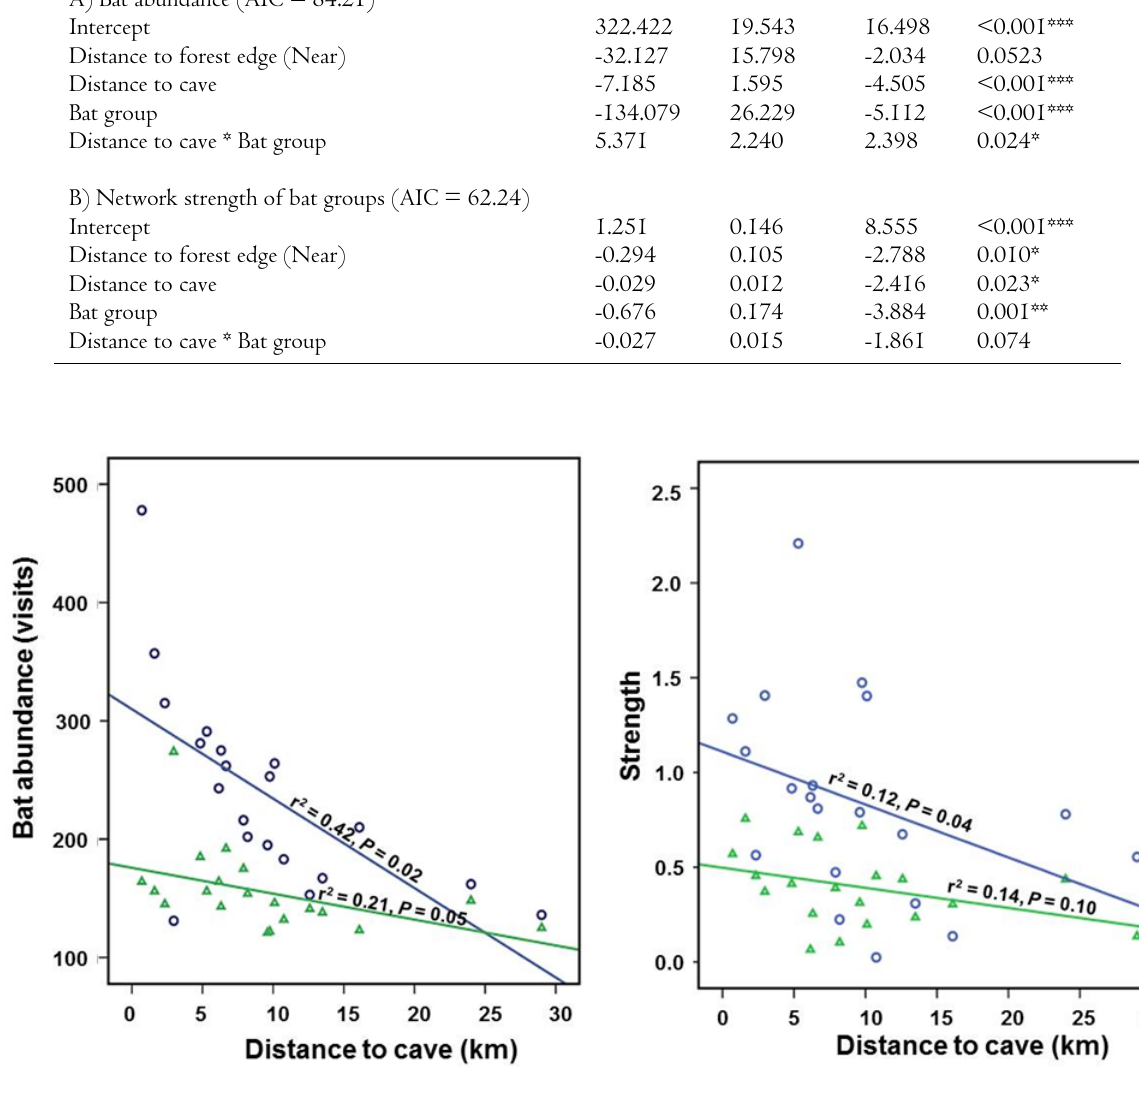
F IGURE 2. The (A) abundance and (B) network strength of nectarivorous bats (blue circles) and frugi-nectarivorous bats (green triangles) plotted against distance from the nearest cave. Each point represents a single fruit orchard in southern